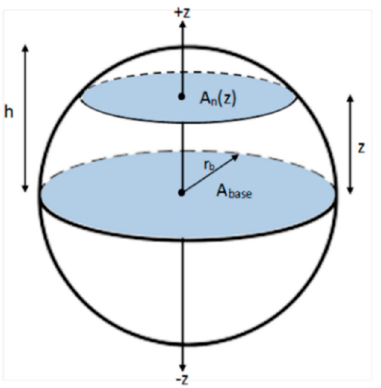
Figure 3. Nanosphere representation with relevant EMT parameters.